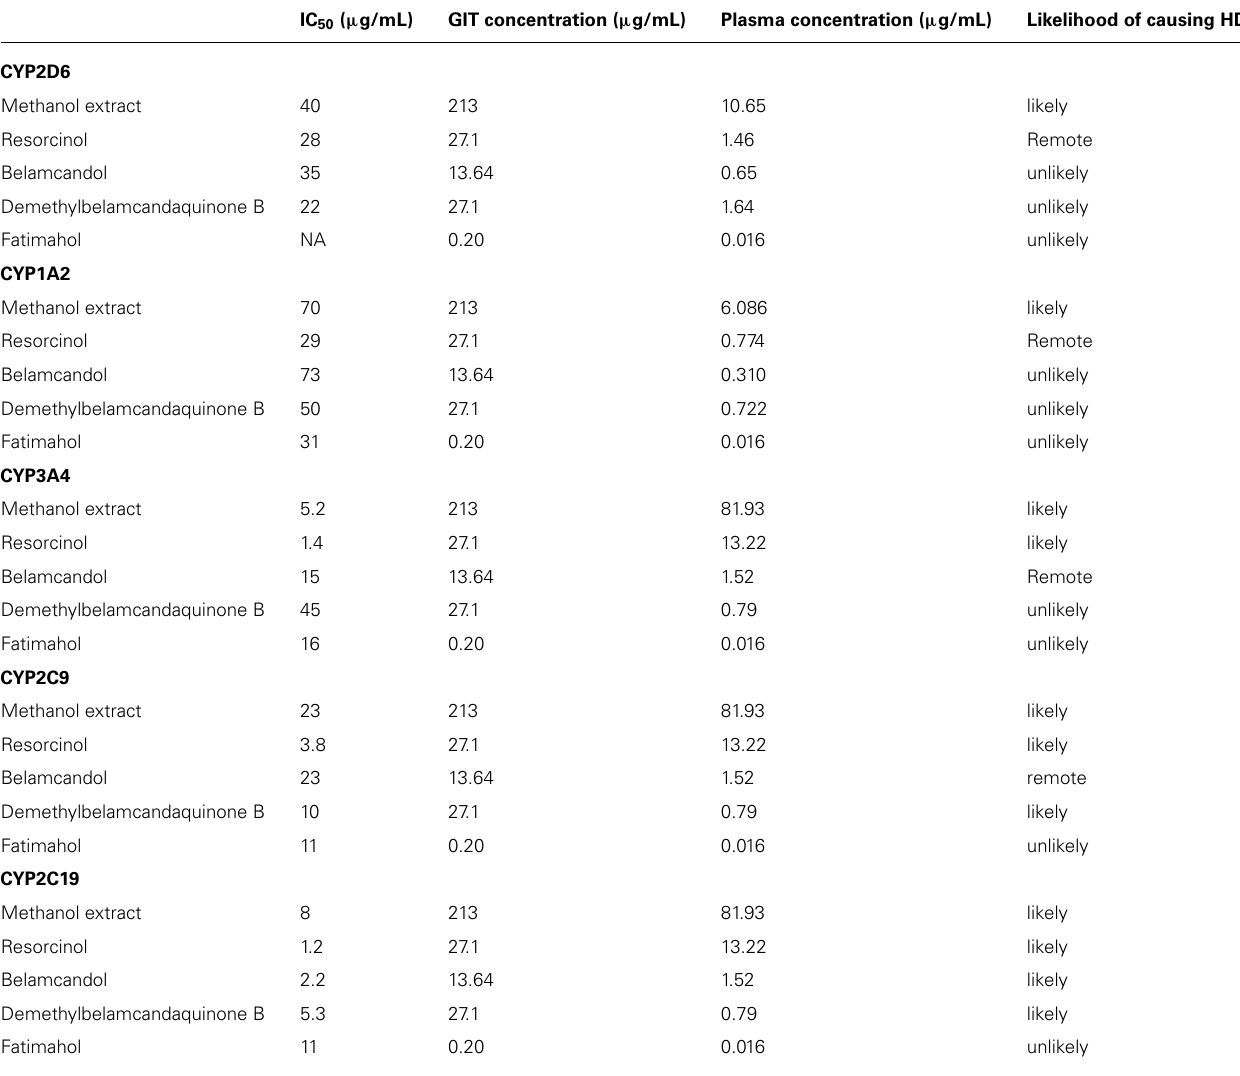
Table 3 | Prediction of KF methanol extract and its constituents to cause herb drug interaction in vivo based on in vitro data. IC 50 ( μ g/mL) GIT concentration ( μ g/mL) Plasma concentration ( μ